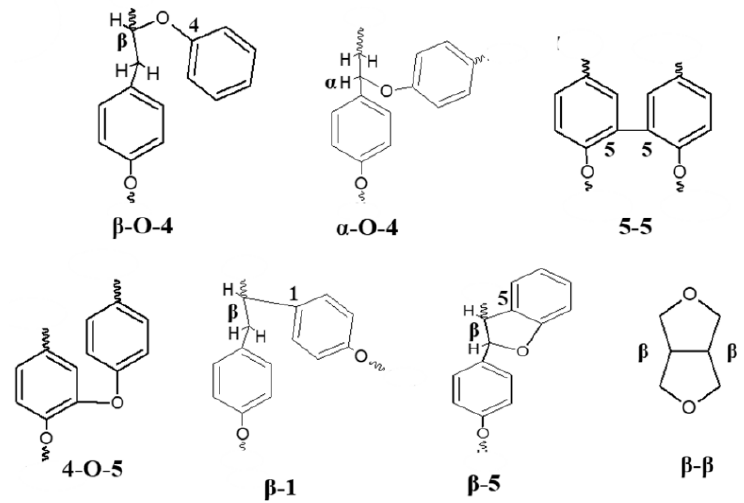
Figure 2. The most common carbon–carbon and ether interlinkages in lignin structure; adapted from [23].